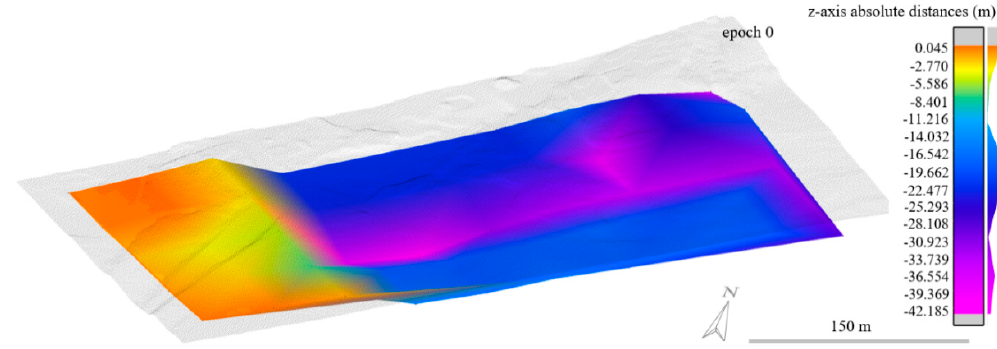
Figure 22. Initial epoch 3D point cloud compared to the determined 75% of total subsidence.